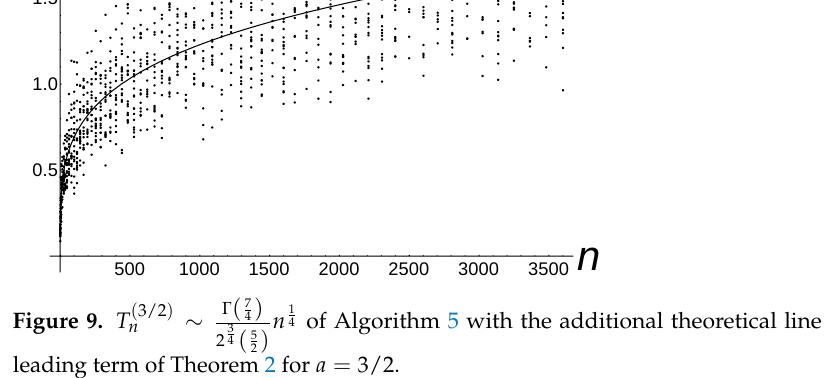
√ Γ ( 3 ) ( 1 ) ∼ √ 2 n of Algorithm 5 with the additional theoretical line according to the leading n 2 2